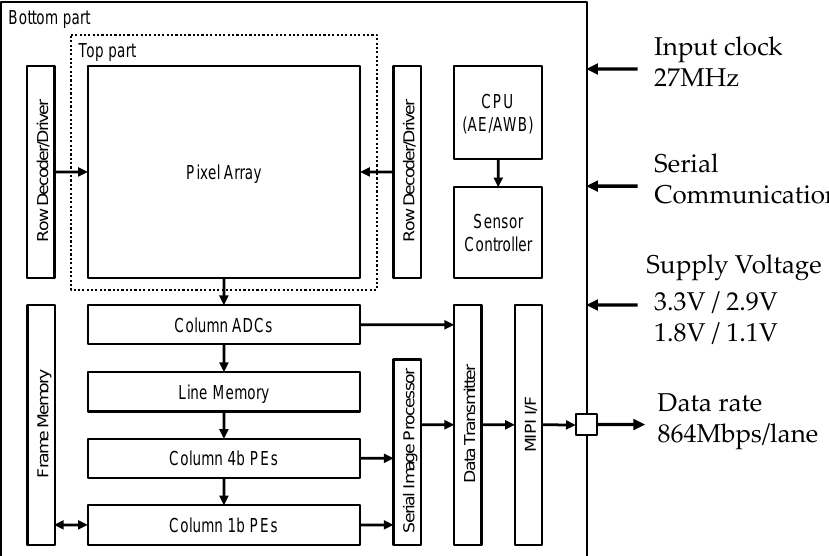
Figure 2. Block diagram of the chip.